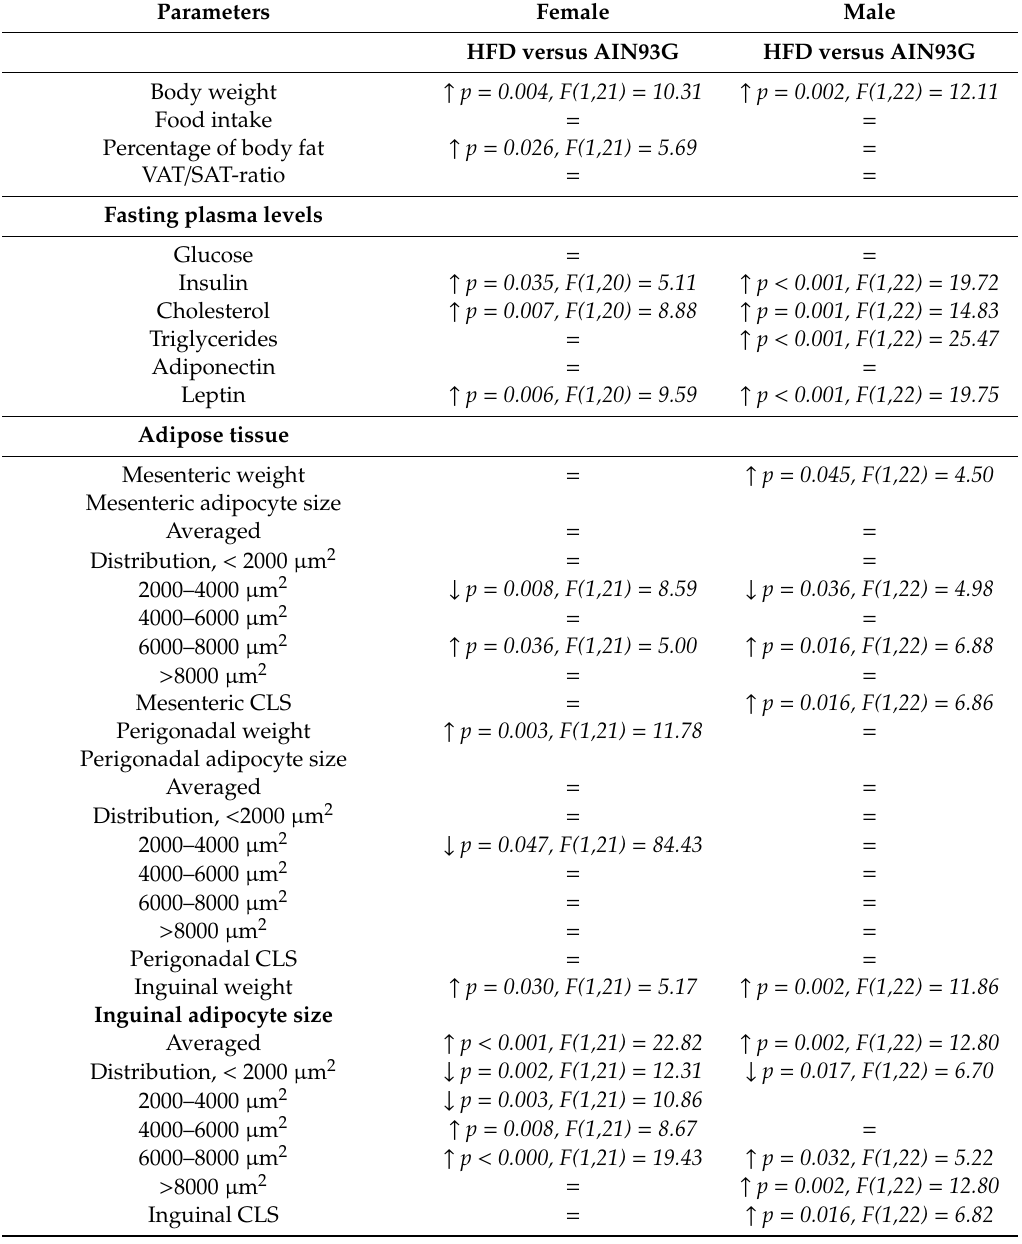
Table 4. Overview of p - and F -values of significant e ff ects between mice fed AIN93G diet or 18 weeks of high fat diet (HFD) for either male or female